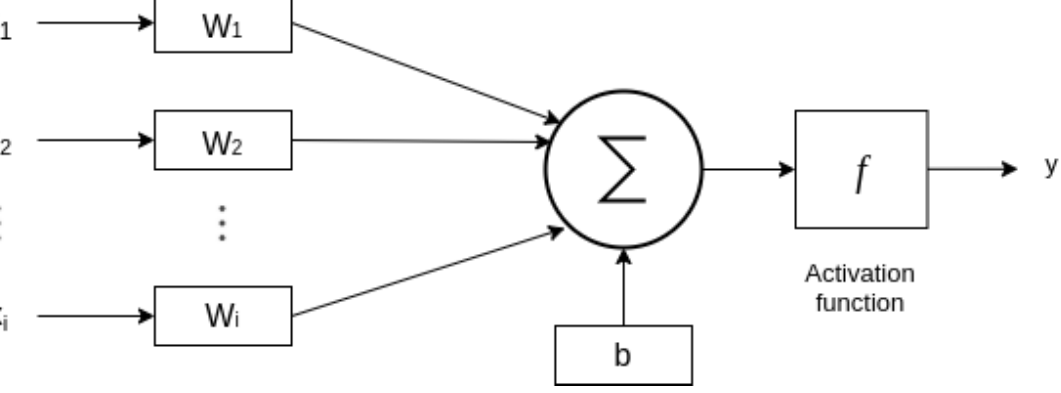
Figure 6. Detail of a single neuron